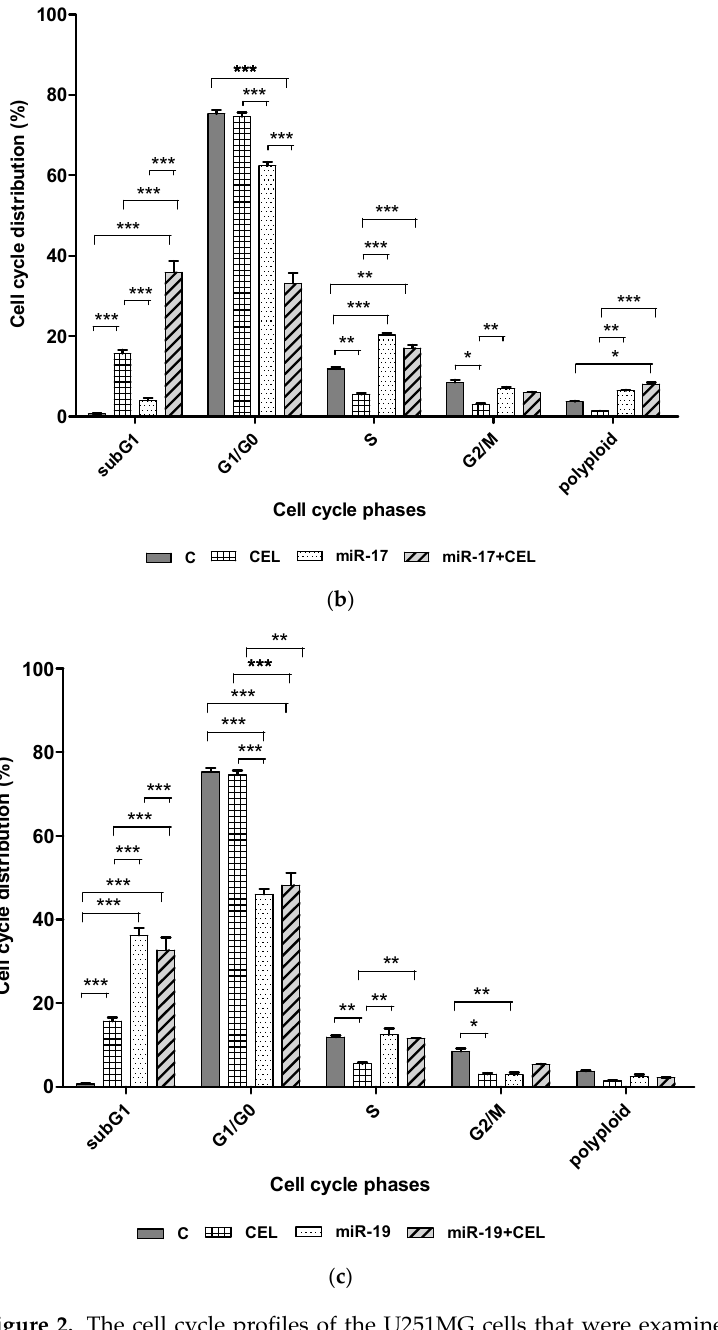
Figure 2. The cell cycle profiles of the U251MG cells that were examined using flow cytometry. ( a ) U251MG cells that had been exposed to celastrol (1 µ M; CEL) for 24 h, the siRNA that is specific for miR-9-2 (0.25 nM; miR-9-2) for 48 h or a combination of the siRNA that is specific for miR-9-2 (0.25 nM) for 48 h and celastrol (1 µ M) for 24 h (miR-9-2 + CEL). ( b ) The U251MG cells that had been exposed to celastrol (1 µ M; CEL) for 24 h, the siRNA that is specific for miR-17 (0.25 nM; miR-17) for 48 h, or a combination of the siRNA that is specific for miR-17 (0.25 nM) for 48 h and celastrol (1 µ M) for 24 h (miR-17 + CEL). ( c ) The U251MG cells that had been exposed to celastrol (1 µ M; CEL) for 24 h, the siRNA that is specific for miR-19 (0.25 nM; miR-19) for 48 h or a combination of the siRNA that is specific for miR-19 (0.25 nM) for 48 h and celastrol (1 µ M) for 24 h (miR-19 + CEL). The results are presented as the percentage contribution of the number of cells that were located in each cell cycle phase, including the subG1 population. The results represent the average of three replicates. Statistically significant * p < 0.05, ** p < 0.01, *** p <